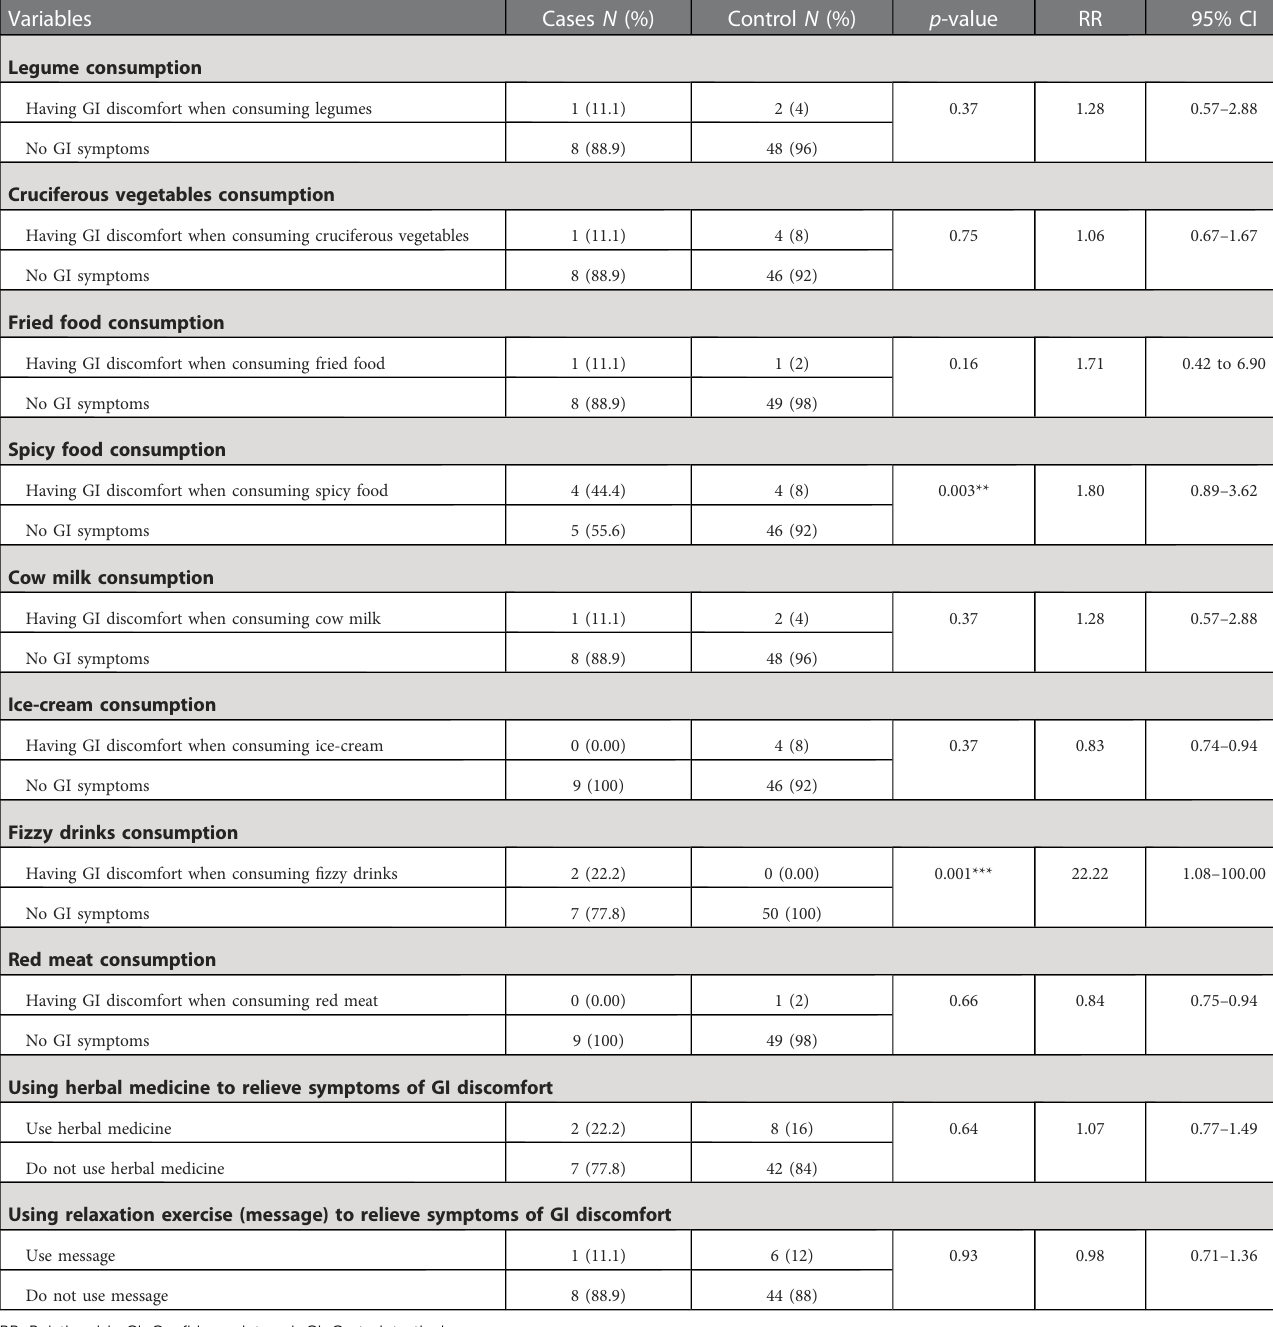
TABLE 6 Relationship between factors affecting functional gastrointestinal diseases and gastrointestinal